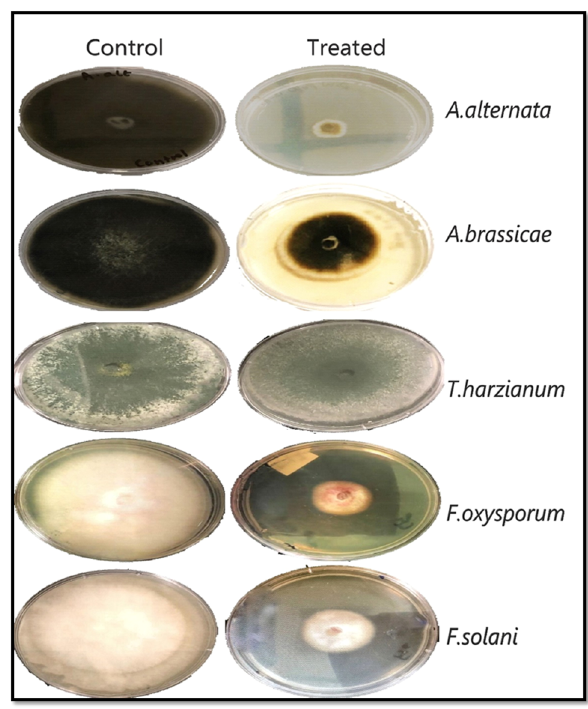
Figure 7: Antifungal activity of Si - AgNPs against plant pathogenic fungi at 80 µg · mL − 1 .